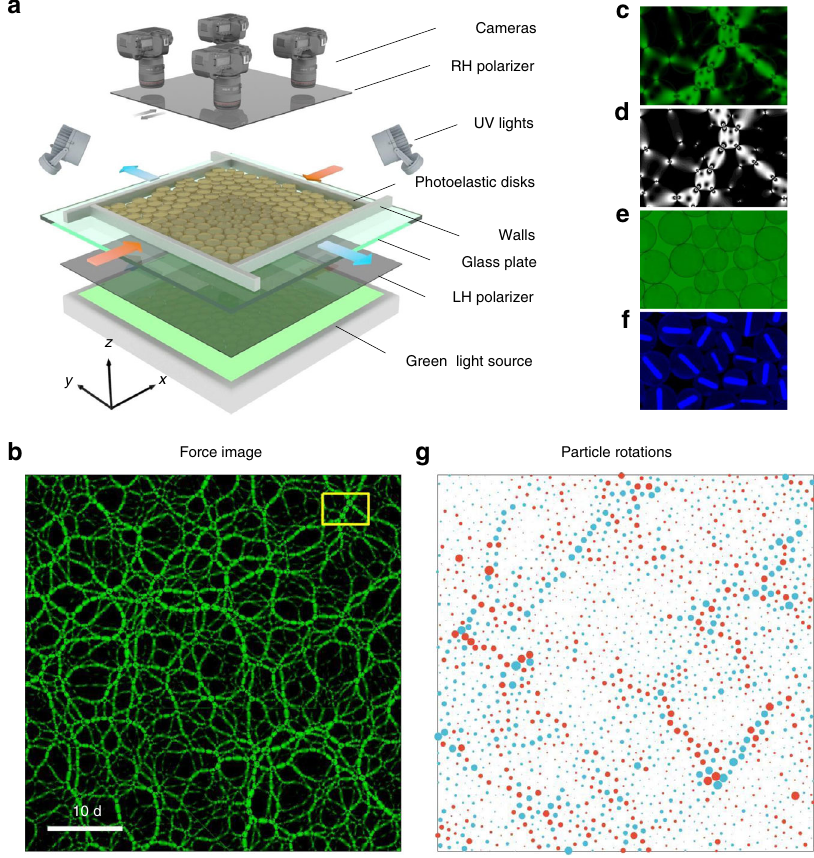
Fig. 1 Schematic of the experimental setup and different types of images recorded. a Experimental setup. b A snapshot of force chains in an isotropically jammed state (an initial state before shear). A yellow rectangle draws a region that is ampli fi ed in c . d A corresponding computer reconstructed image using the measured vector contact forces. e A corresponding normal image of particle con fi guration. f A corresponding UV image for tracking particle rotations. g Spatial distribution of particle rotations, measured from the initial sate γ = 0 in b to γ = 0.75%. The sizes of red/blue circles are proportional to the magnitudes of counterclockwise/clockwise rotations. Scale bar = 10d, where d = 1 cm, is the diameter of a small particle.